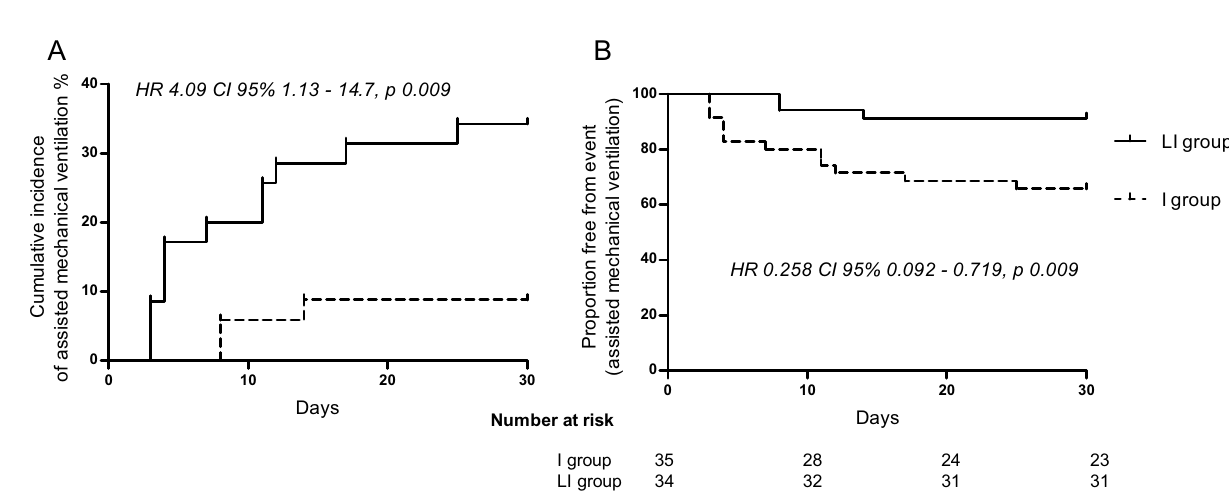
Figure 2. Incidence of assisted mechanical ventilation ( A ), and Kaplan–Meier analysis for assisted mechanical ventilation-free between the study groups ( B